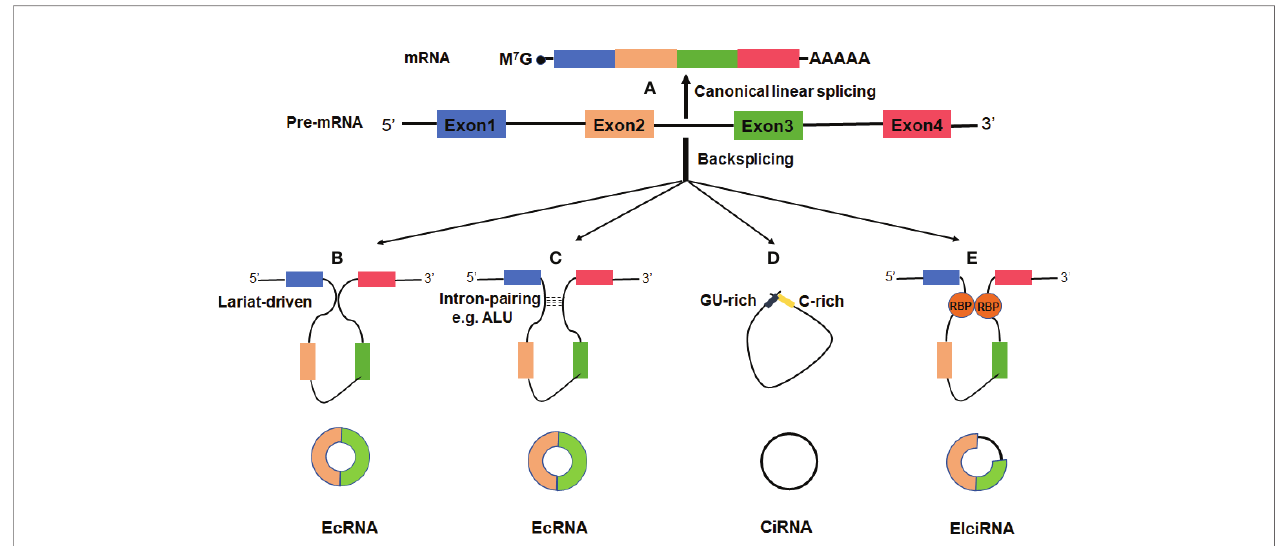
FIGURE 1 | Biogenesis of three major types of circRNAs. (A) A linear mRNA is formed by canonical splicing from pre-messenger RNA (pre-mRNA). (B – E) CircRNAs are generated by backsplicing from pre-mRNA. (B) Lariat-driven circularization, exon-skipping leads to an exon-containing lariat whose restricted structure facilitates circularization. (C) Intro-pairing-driven circularization is mediated by base-pairing between inverted repeat elements such as ALU complementarity. (D) CiRNA biogenesis is mainly dependent on GU-rich motif and C-rich sequence. (E) RNA-binding proteins (RBP) serving as trans-acting factors can bring two splicing sites close together to promote